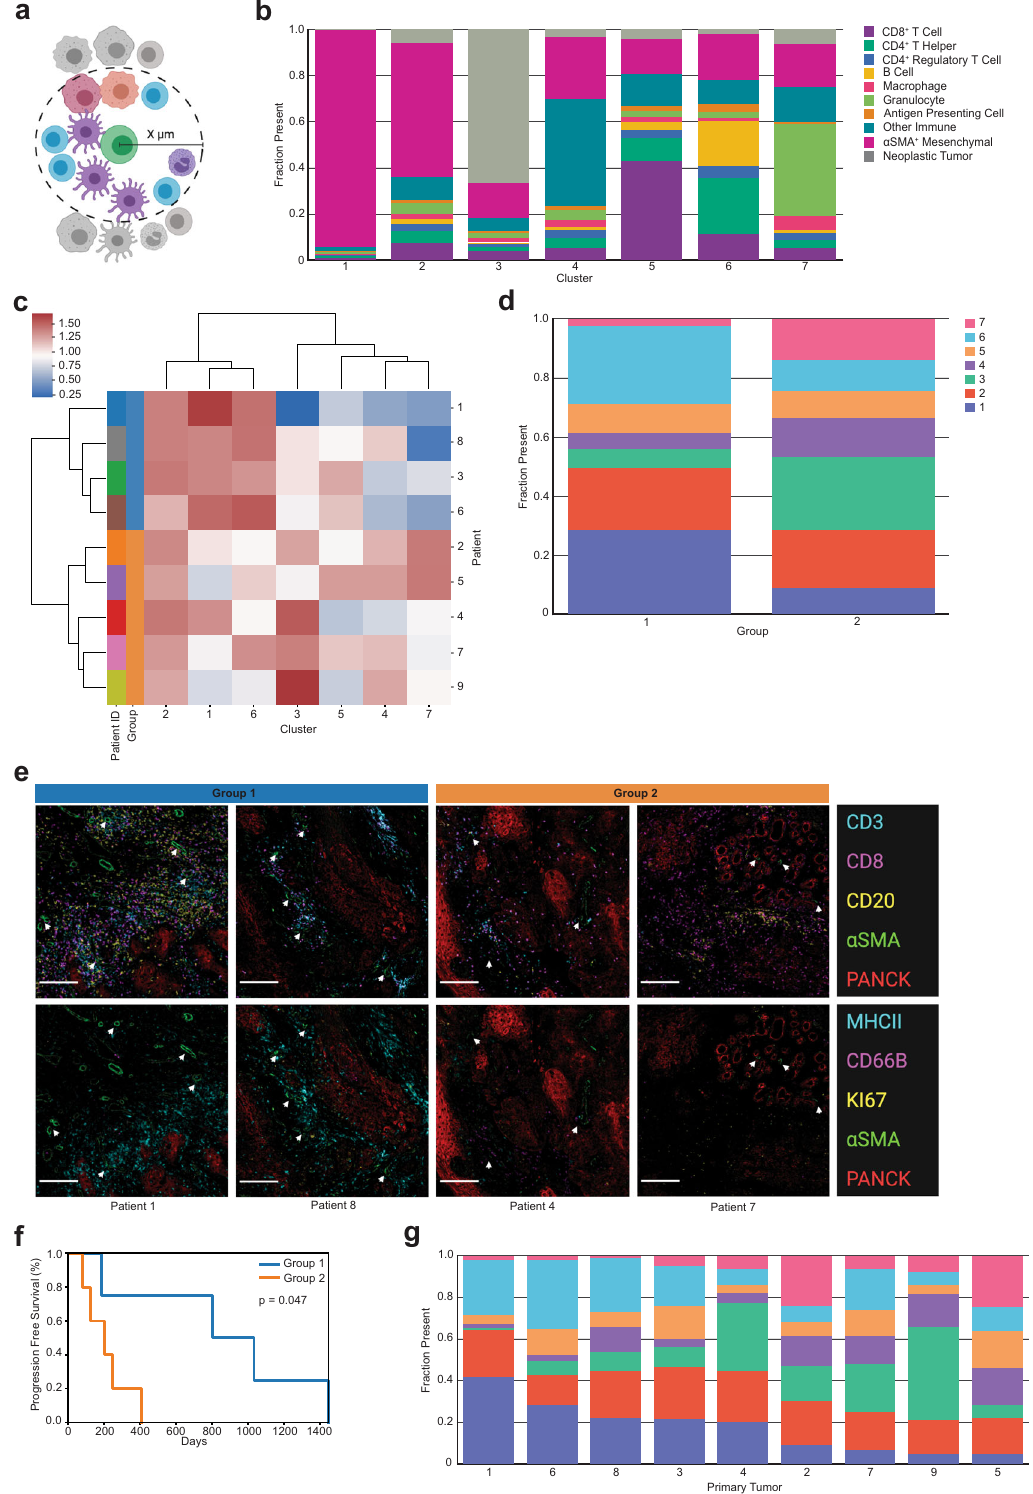
Spatial compartmentalization associated with longer progression free survival To investigate how spatial mixing correlated with patient outcome, we averaged the mixing scores across regions and assigned a fi nal mixing score and spatial label for each